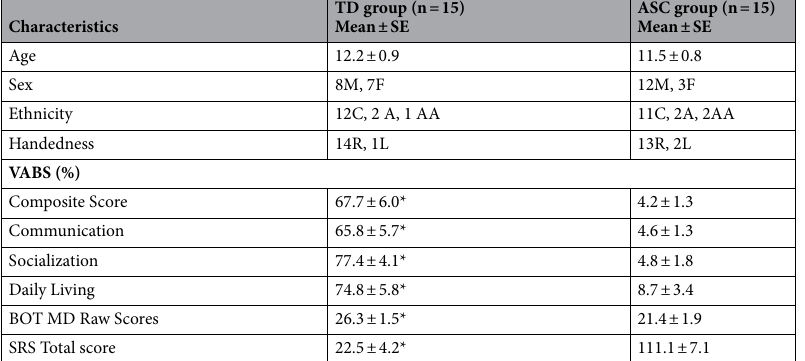
Table 2. Demographic information and questionnaires data for ASC and TD groups. SE standard error, VABS Vineland Adaptive Behavioral Scale, 2nd edition, BOT MD Manual Dexterity subtest of the Bruininks– Oseretsky Test of Motor Proficiency, 2nd edition, SRS Social Responsiveness Scale, 2nd Edition, M male, F female, C Caucasian, A Asian, AA African-American, R right-handed, L left-handed, *indicates a